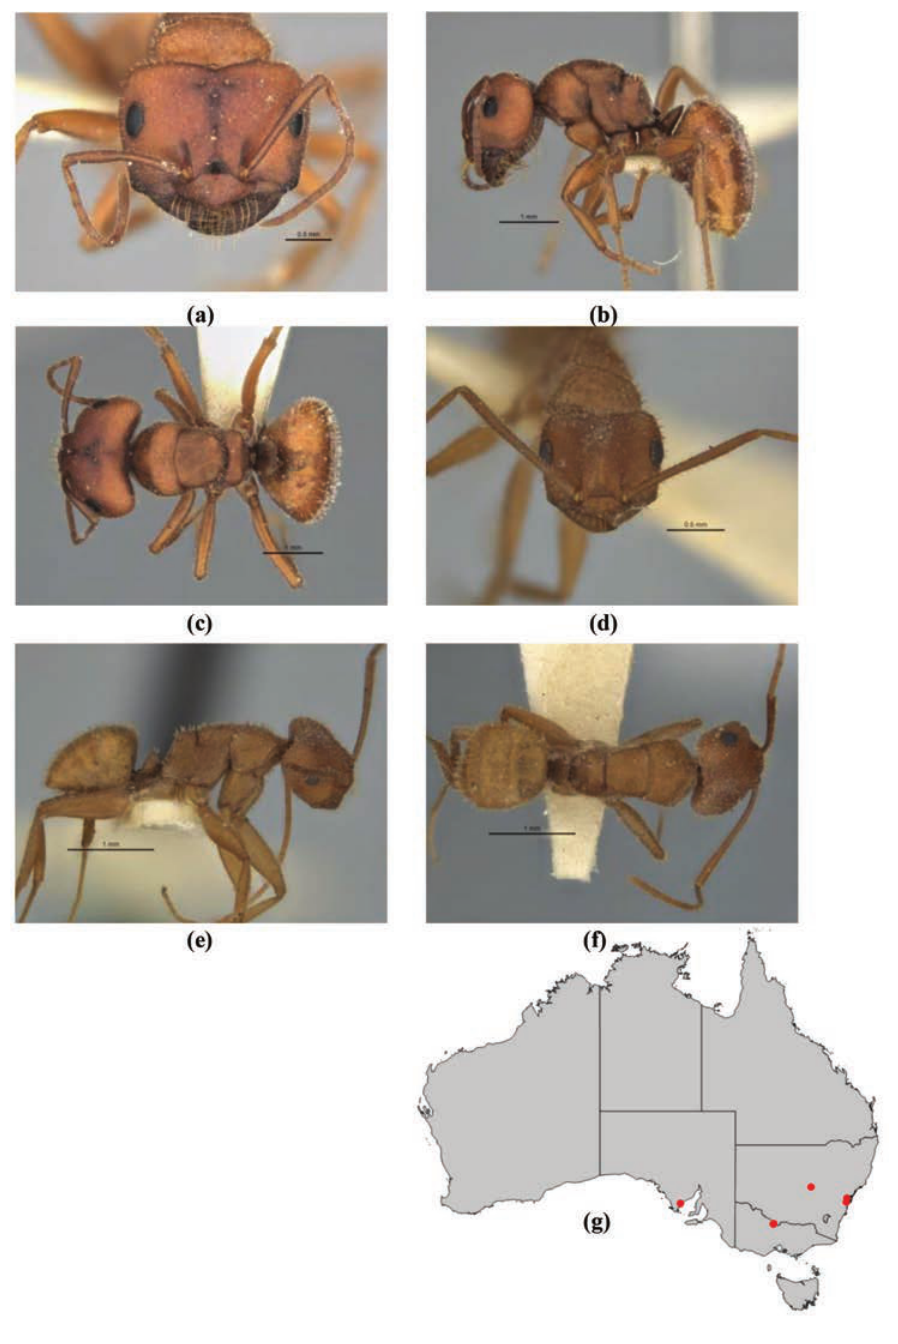
Figure 90. Melophorus fulvihirtus Clark: non–type major worker (ANIC32-900178) frons ( a ), profile ( b ) and dorsum ( c ); non–type minor worker (ANIC32-900076) frons ( d ), profile ( e ) and dorsum ( f ); distribu- tion map for the species ( g ). Low resolution scale bars: 1 mm ( b, c , e, f ); 0.5 mm ( a, d